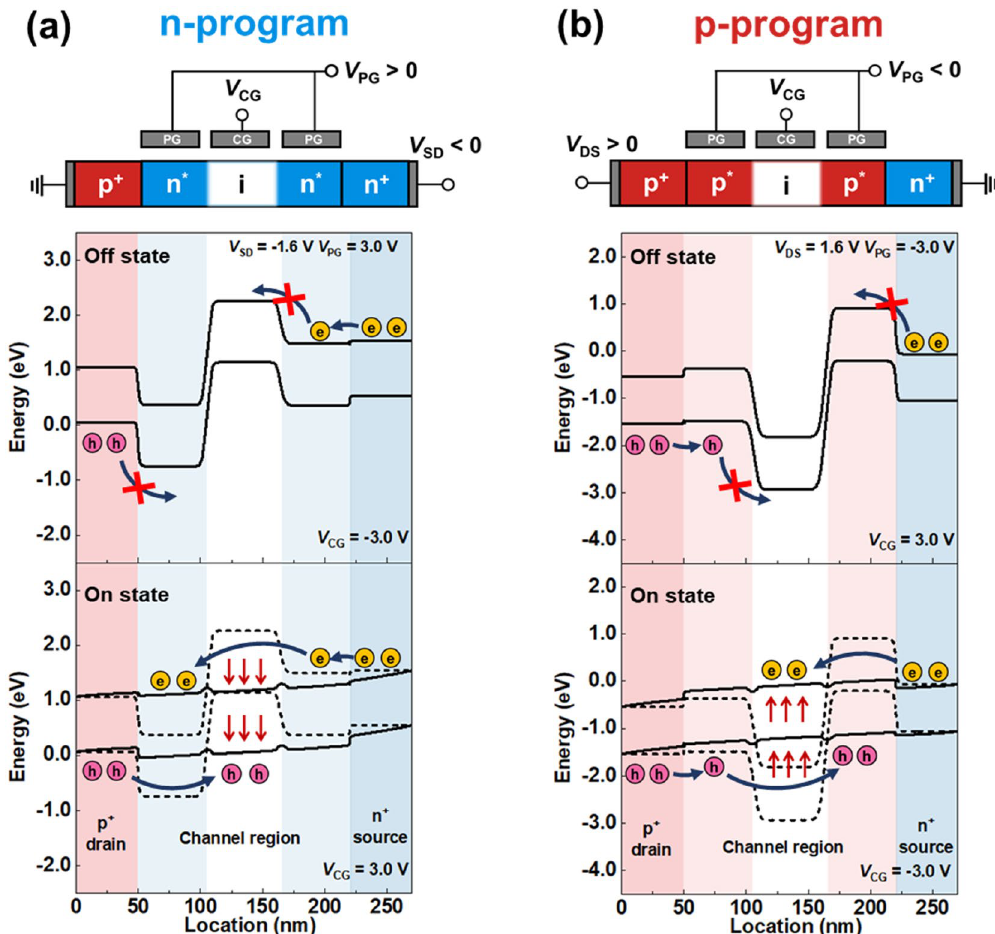
Figure 2. Operating principle of triple-gate FBRAM Energy band diagrams of triple-gate FBRAMs in on and off states of ( a ) n- and ( b ) p-program modes. According to polarity of V PG , potential barriers and wells are created in energy band diagrams for operating in the corresponding program mode. The potential barriers and wells play key roles in triggering the positive feedback